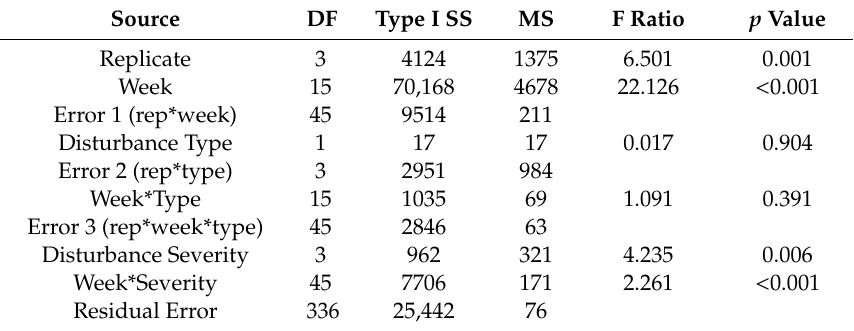
Table A1. Split-plot time-series analysis of variance (ANOVA) table for daily aboveground wood net primary production (ANPP w ), presented in Figure 3 of the manuscript. Week and disturbance type main e ff ects and their interaction were tested against more conservative error terms to account for restricted randomization, whereas the main e ff ect disturbance severity and its interaction with week were tested against the residual error. Asterisks indicate an interaction between two or more parameters.